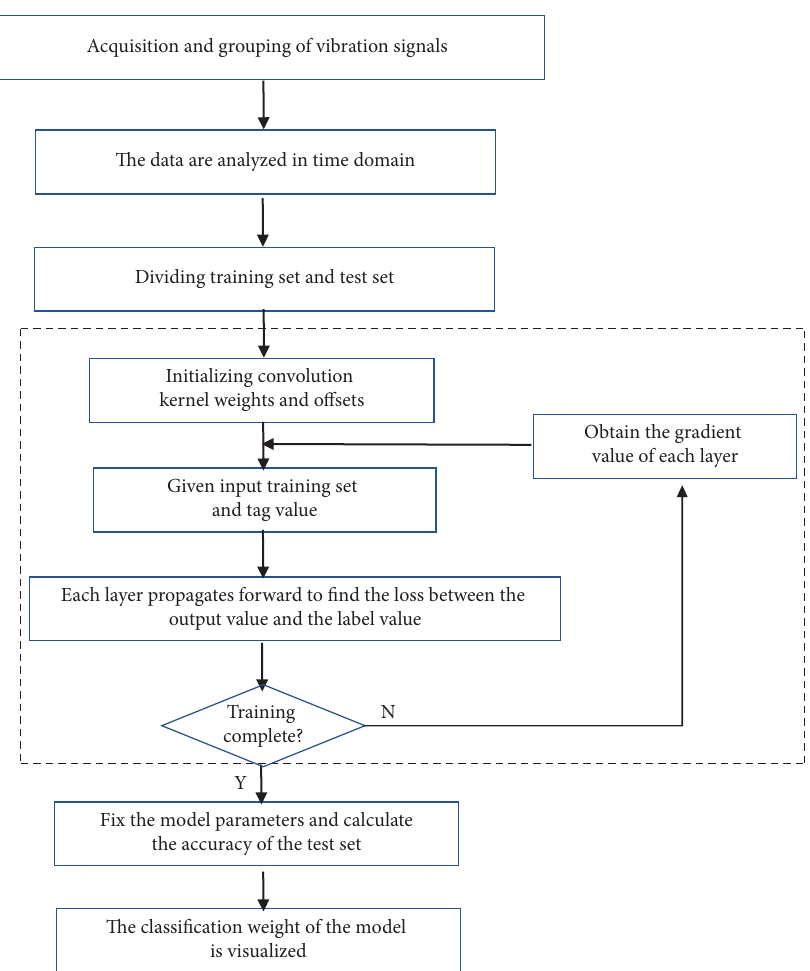
Figure 11: Technology